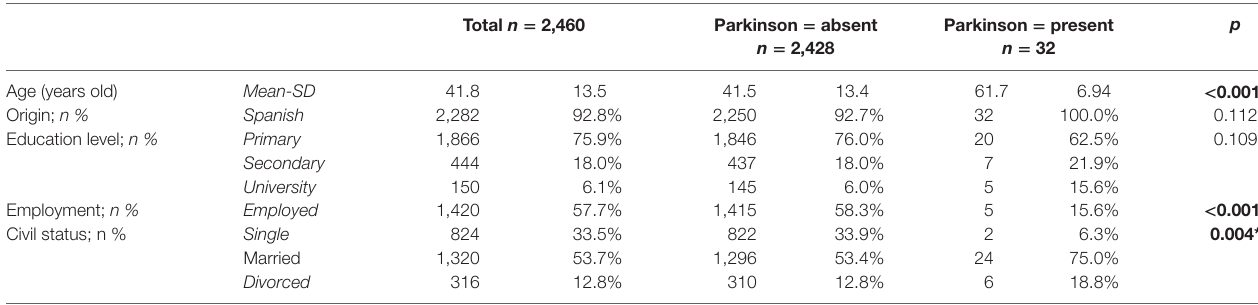
TaBle 1 | Description of the